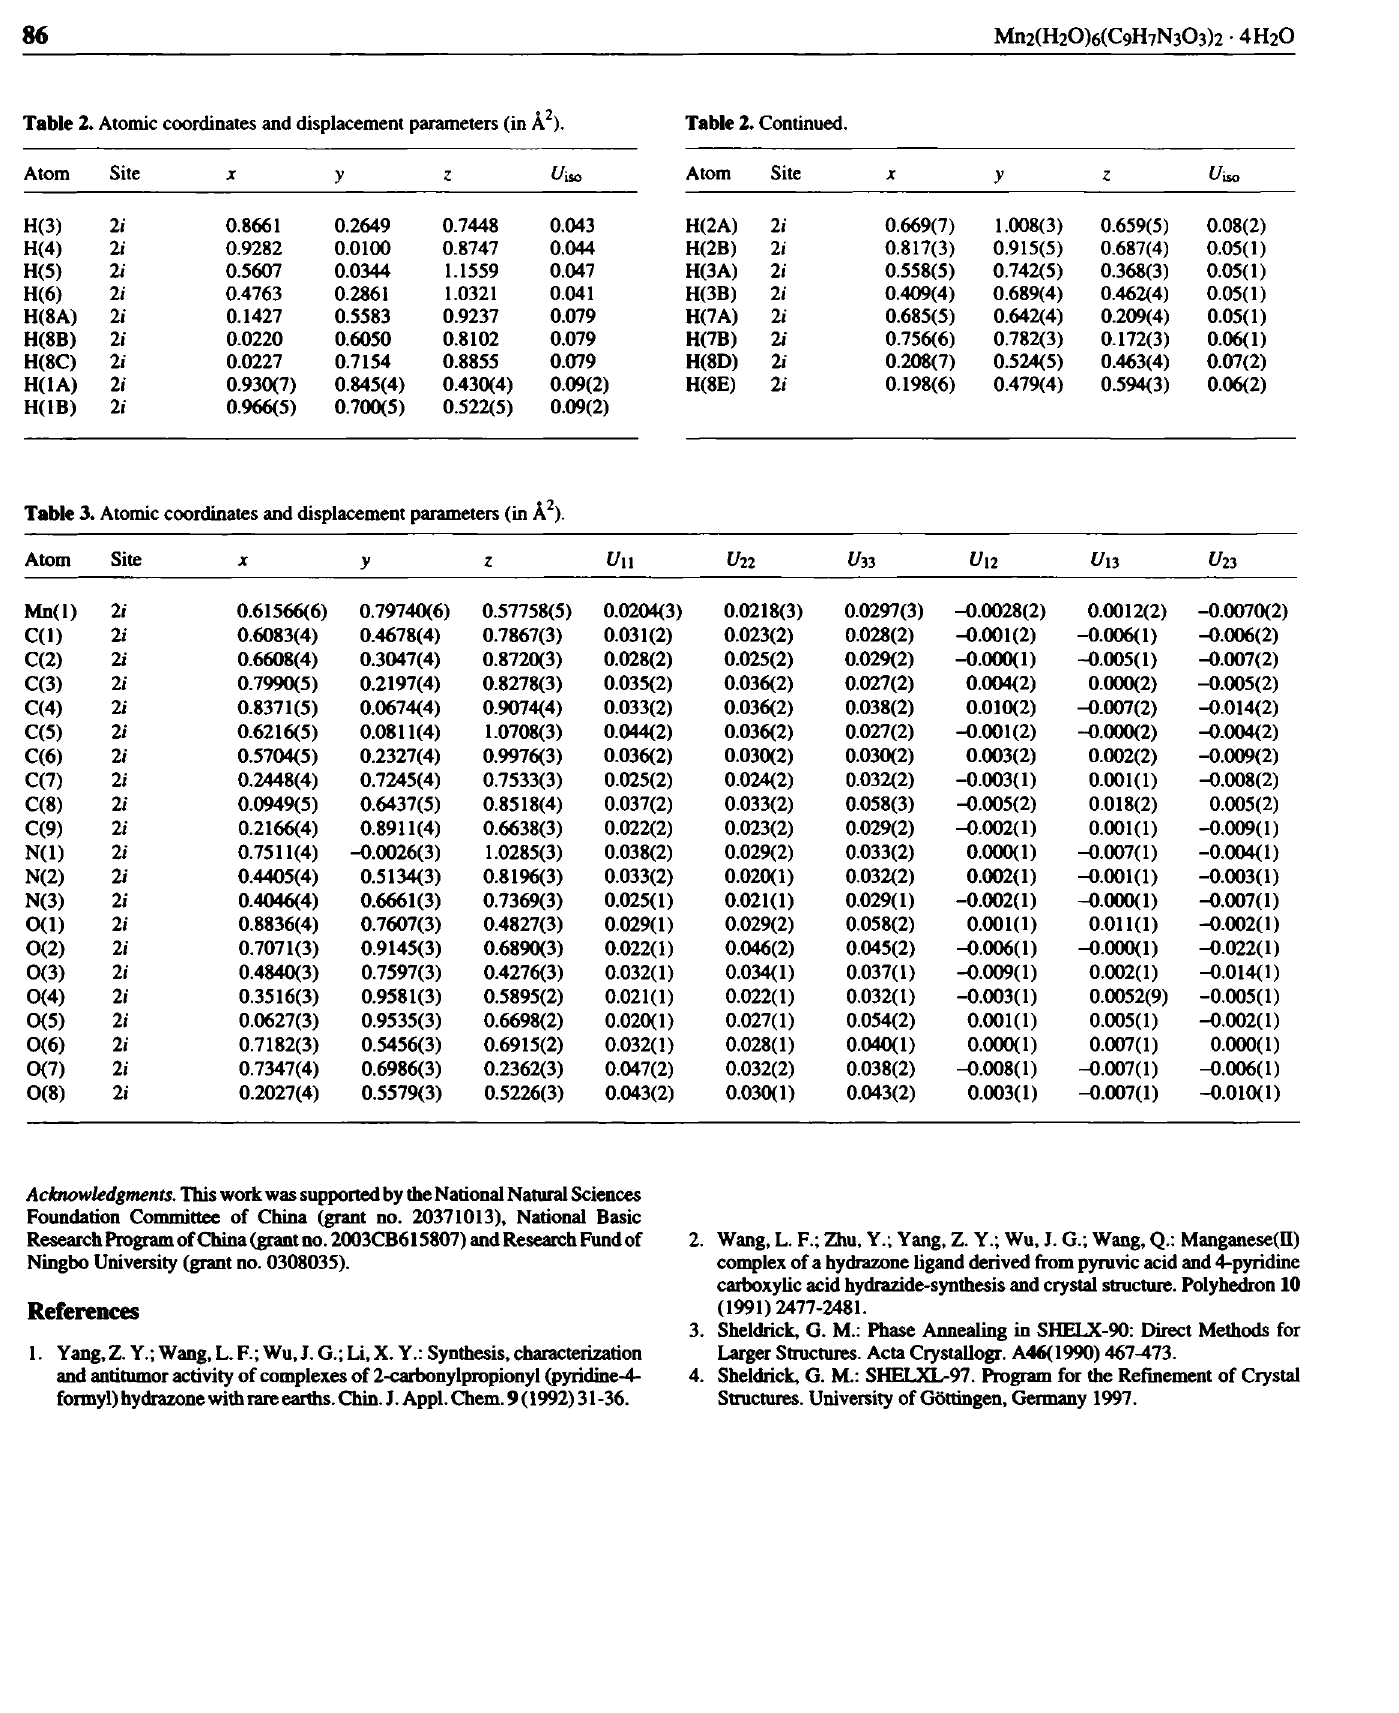
Table 2. Atomic coordinates and displacement parameters (in A 2 ). Table 2. Continued.